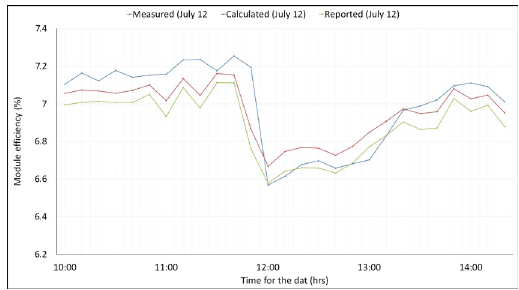
Figure 3. Module temperature graph for clear sky day 12 th Oct of a-Si PV technology. Figure 2. Module temperature graph for monsoon day 12 th July of a-Si PV technology.